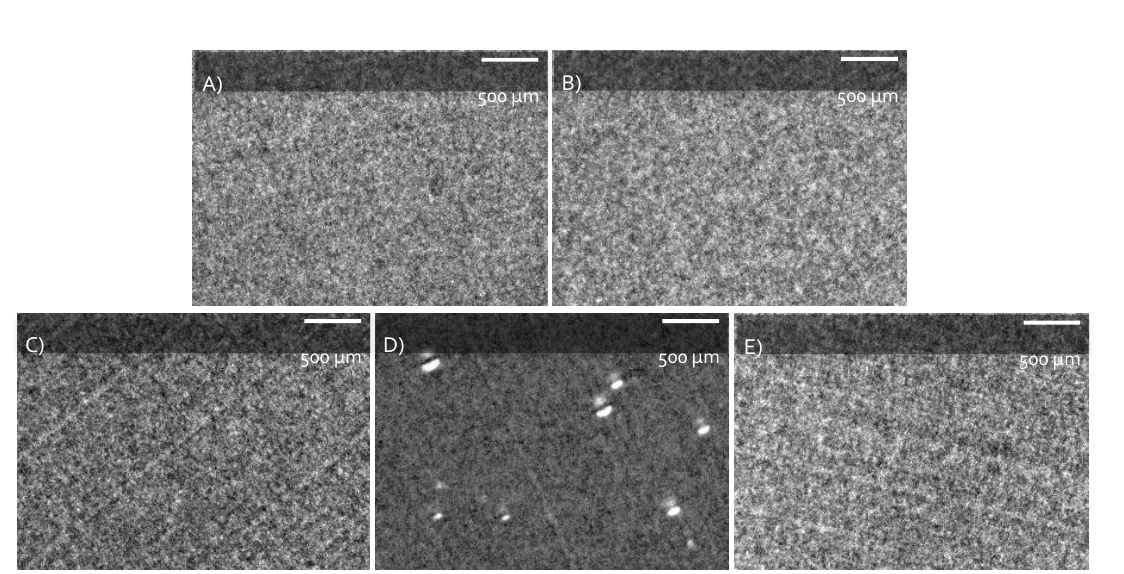
Figure 2. TEM micrographs of neat PMMA and IL-modified PMMA materials: ( A ) neat PMMA; ( B ) PMMA / (C 4 mIm)(PF 6 ); ( C ) PMMA / (N 1,1,1,4 )(PF 6 ); ( D ) PMMA / (N 1,1,1,6 )(Br); and ( E ) PMMA / (N 1,1,1,6 )(TFSI) (2 wt.% IL).